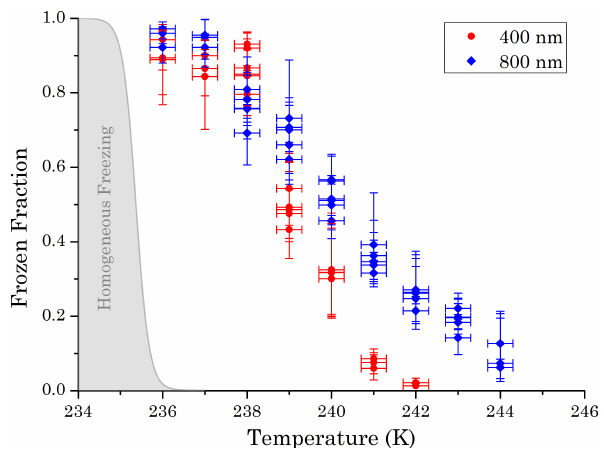
Fig. 4. Temperature dependent frozen fraction of 400nm and 800nm kaolinite particles for a residence time of 9seconds. Ho- mogeneous freezing conditions, calculated using the homogeneous nucleation rates reported in Earle et al. (2010), are shaded in grey. Error bars represent the uncertainty in the frozen fraction due to the classification of particles as ice crystals or droplets (see Sect. 2.4 for